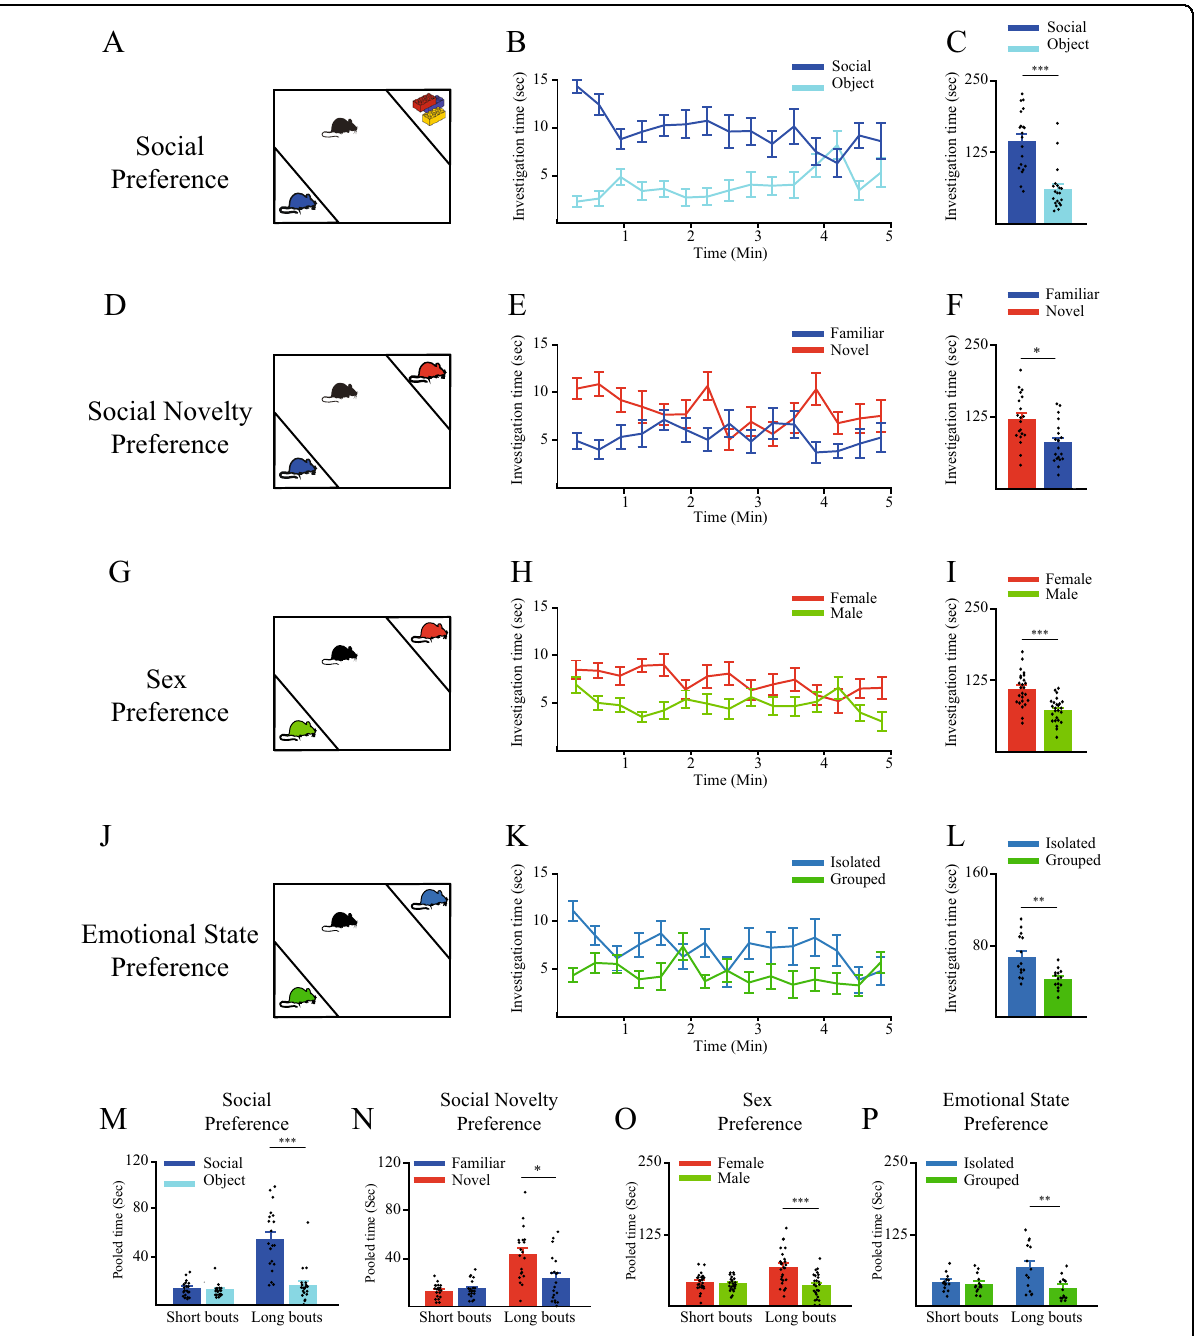
Fig. 1 Social discrimination tests conducted with adult C57BL\6J male mice. A Schematic depiction of the social preference (SP) test. B Mean investigation time measured separately for each stimulus (20-s bins) across the SP test ( n = 20). C Mean investigation time summed separately for each stimulus throughout the SP test. D – F As in A – C , respectively, for the social novelty preference (SNP; n = 20) test. G – I As in A – C , respectively, for the sex preference (SxP; n = 25) test. J – L As in A – C , respectively, for the emotional state preference (ESP; n = 14) test. ( M – P ) Mean investigation time for each of the stimuli, pooled separately for short (<7 s) and long ( ≥ 7 s) investigation bouts, for the SP ( M ), SxP ( O ), and ESP ( P ) tests shown above ( A – L ). Note that the preference for a speci fi c stimulus is re fl ected only by the long bouts in all of these tests. Post hoc paired t-tests following main effect in mixed-model ANOVA test; M- short bouts: t 19 = − 0.576, p = 0.571, long bouts: t 19 = − 4.64, p < 0.001; N- short bouts: t 19 = − 0.93, p = 0.364, long bouts: t 19 = 2.78, p < 0.05; O-short bouts: t 24 = 0.973, p = 0.34, long bouts: t 24 = 4.825, p < 0.001; P-short bouts: t 13 = 0.708, p = 0.492, long bouts: t 13 = 3.167, p < 0.01. * p < 0.05, ** p < 0.01, *** p < 0.001, paired t -test following the main effect in ANOVA test. All error bars represent